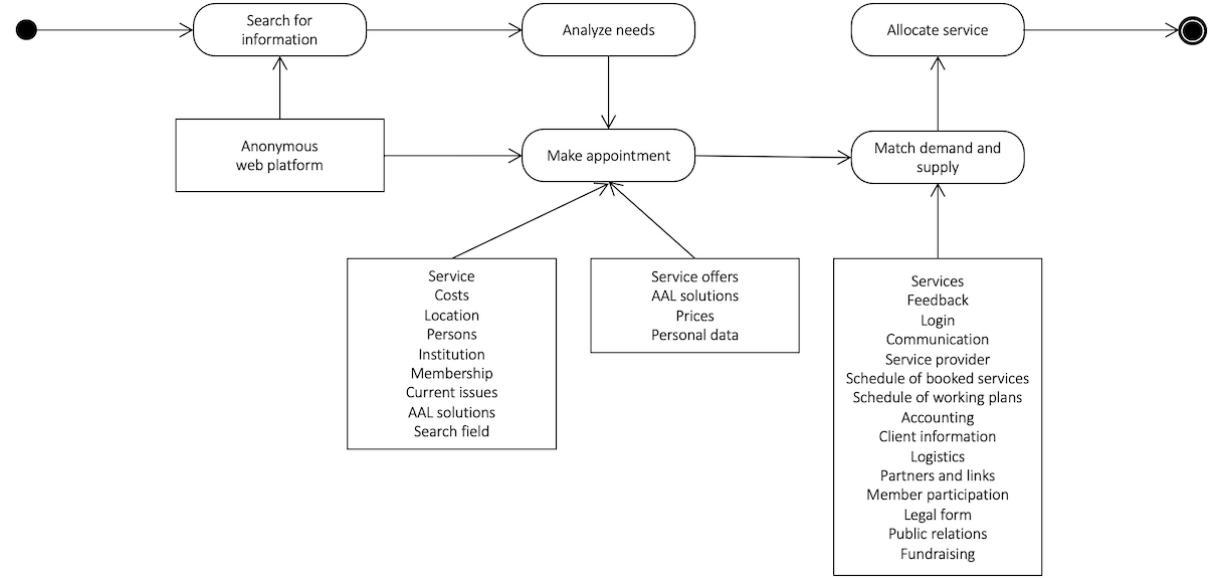
Figure 1. Workflow model of a community-based health care organization, including potential tools for support from a web platform. AAL: Active and Assisted